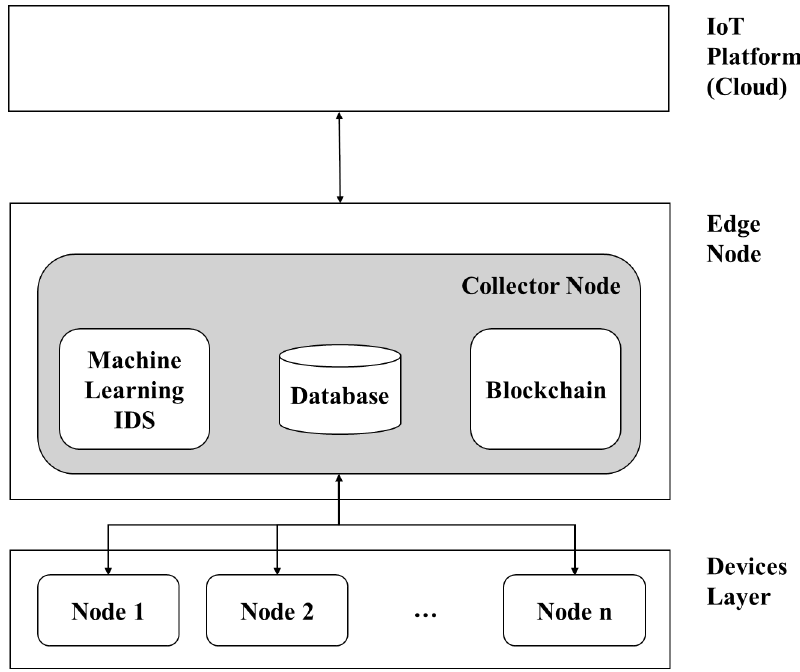
Figure 1. Proposed